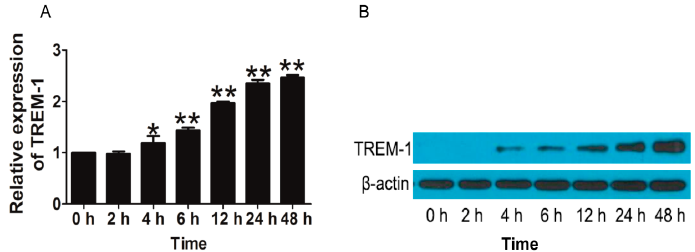
Figure 2. TREM-1 mRNA expression in U937 cells after lipopolysaccharides (LPS) stimulation. U937 cells were treated with 100 ng/mL of LPS for 0, 2, 4, 6, 12, 24 and 48 h, respectively. TREM-1 mRNA ( A ) and protein ( B ) levels were measured by RT-PCR and Western blots, respectively. All results are presented as mean ˘ standard deviation (SD) of three independent experiments, each performed in triplicate. * p < 0.05, ** p < 0.01 versus 0 h.